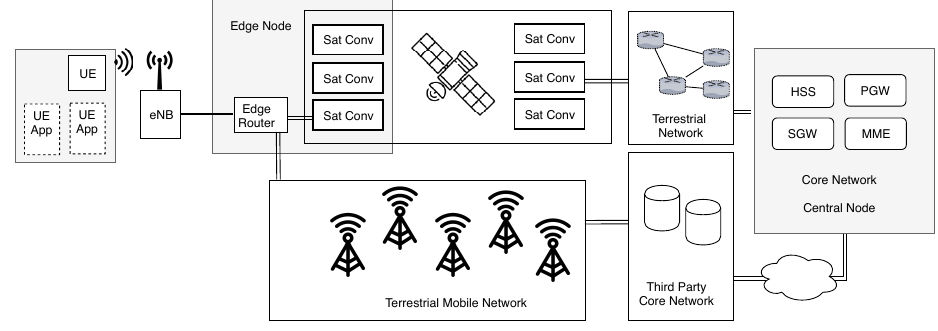
Figure 4. Architecture of the 2018 SATis5 testbed.